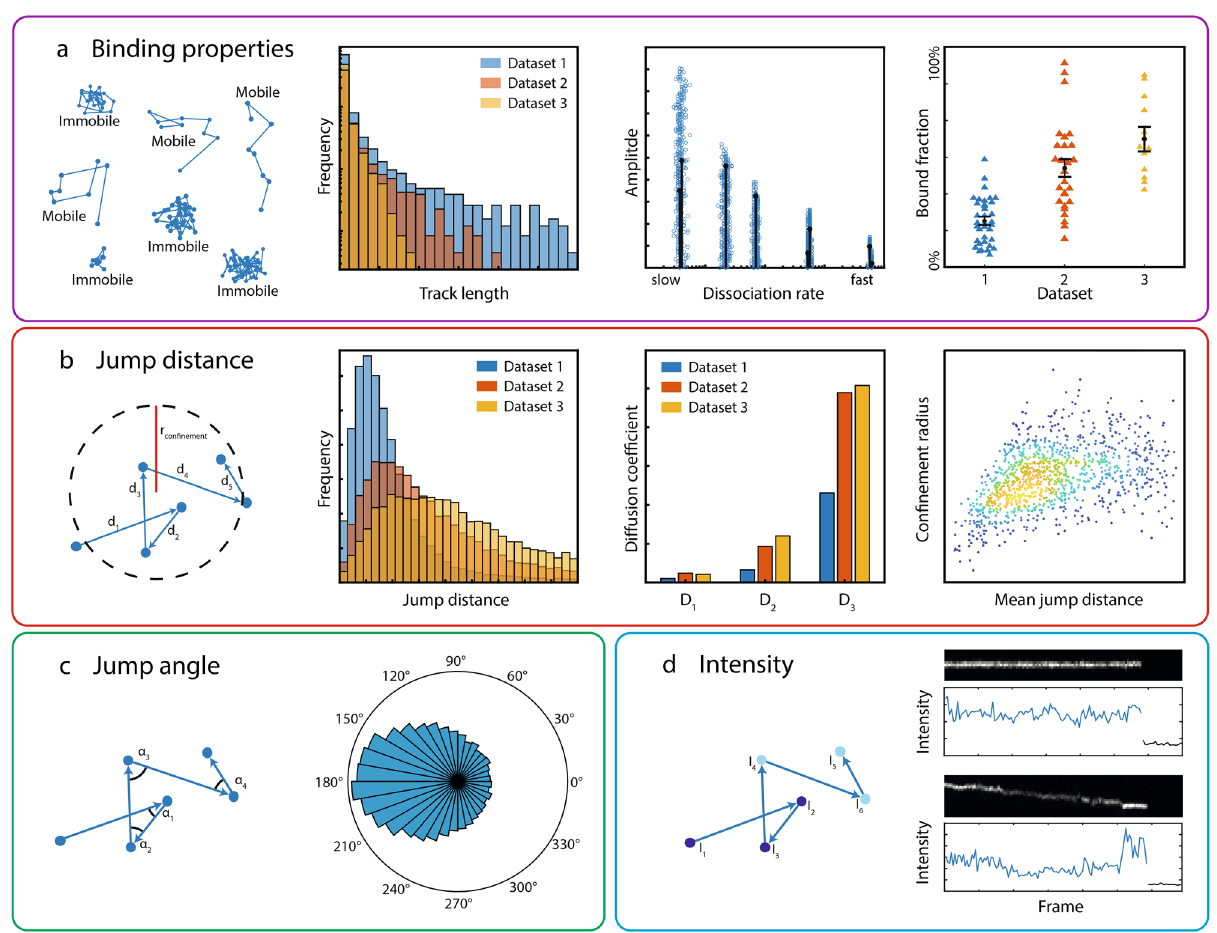
Figure 2. Examples of evaluation parameters and display options. ( a ) Duration of all tracks (track lengths) are collected in a histogram. Bound molecules can be segmented by the choice of tracking parameters, i.e. the tracking radius. For molecules classified as bound, the dissociation rate spectrum via GRID and bound fractions can be obtained. ( b ) Diffusion coefficients and confinement radii can be computed from jump distance distributions. ( c ) Angles between consecutive jumps are calculated and displayed in a polar histogram. ( d ) Each track can be individually explored by plotting the intensity over time together with a kymograph. The upper and lower graphs show examples of an immobile and mobile molecule,